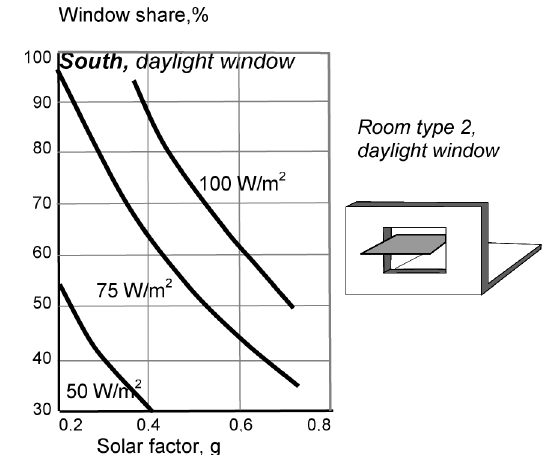
Fig. 13. Possible combinations of window glass share and solar factor for room type 1 with a daylight window for a maximum 2 cooling power demand of 50, 75, or 100 W/m In the case of a daylight window for south orienta- tions, the cooling power demand is decreased compared to an ordinary window and it is possible to use larger window shares without increasing the cooling power